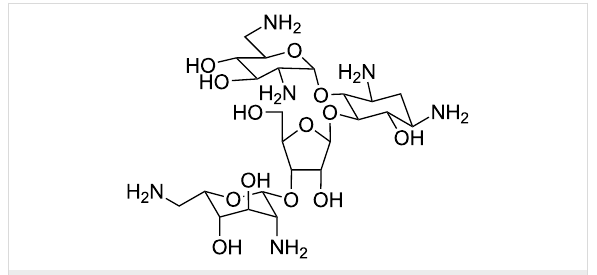
Figure 5: Structural representation of